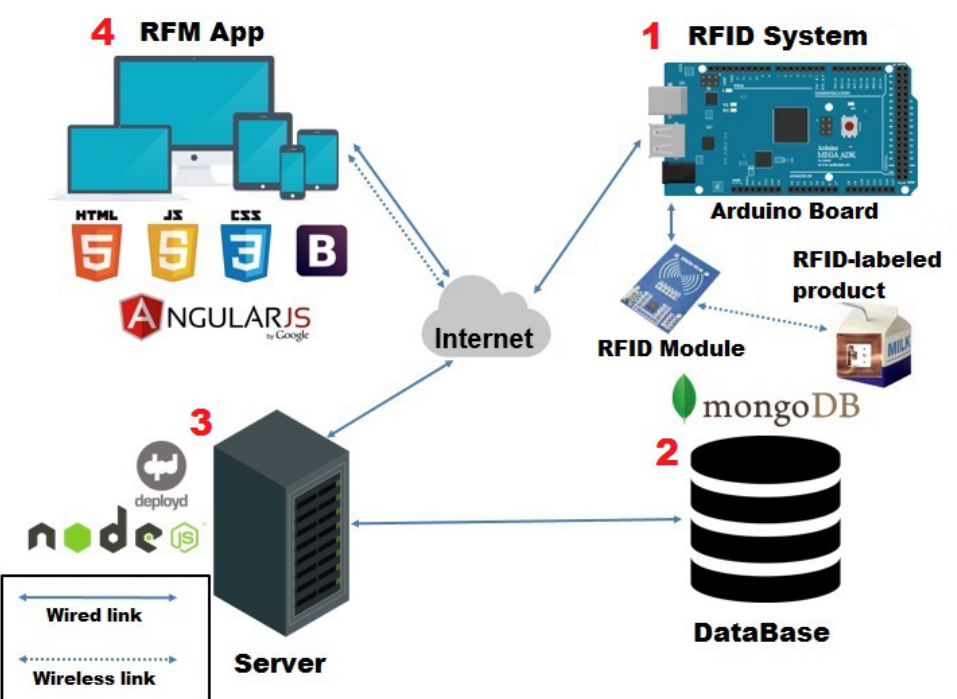
Figure 1. RFM is composed of diverse hardware and software